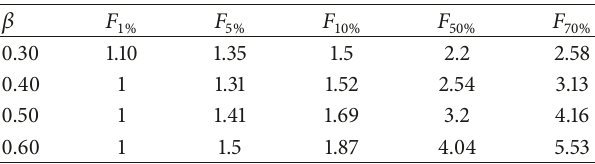
Table 4: Seismic margin factors for different 𝛽 values calculated by Kennedy